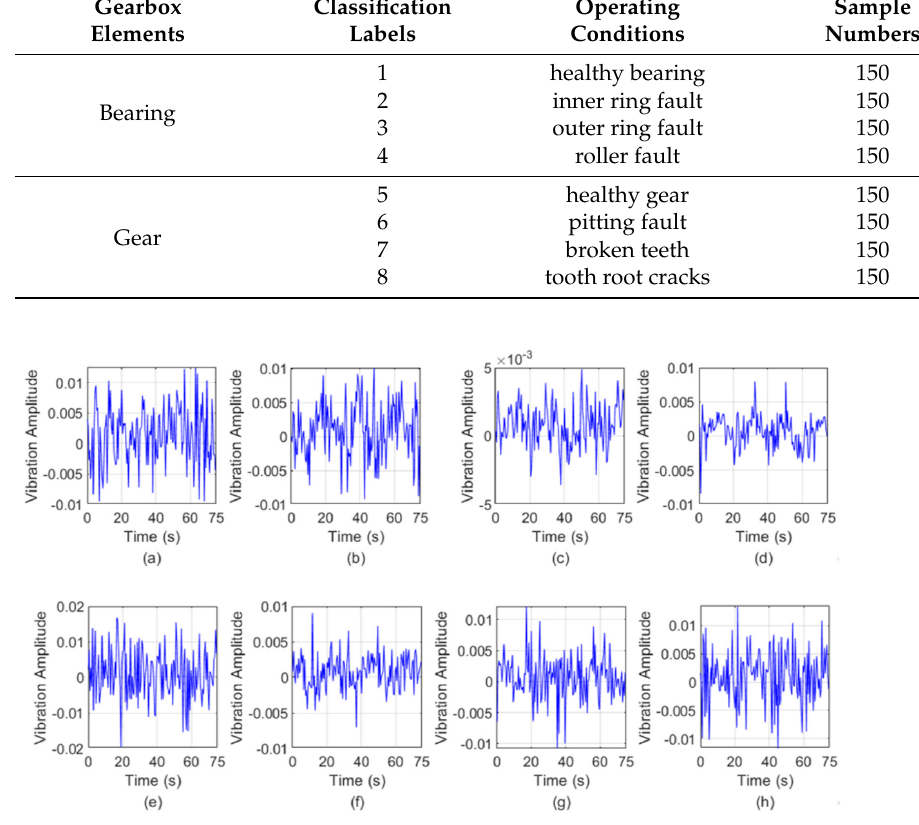
Figure 18. Sampled vibration signals in eight operating conditions. ( a ) Healthy bearing, ( b ) bearing inner ring fault, ( c ) bearing outer ring fault, ( d ) bearing roller fault, ( e ) healthy gear, ( f ) gear pitting fault, ( g ) gear broken tooth fault, ( h ) gear tooth root crack